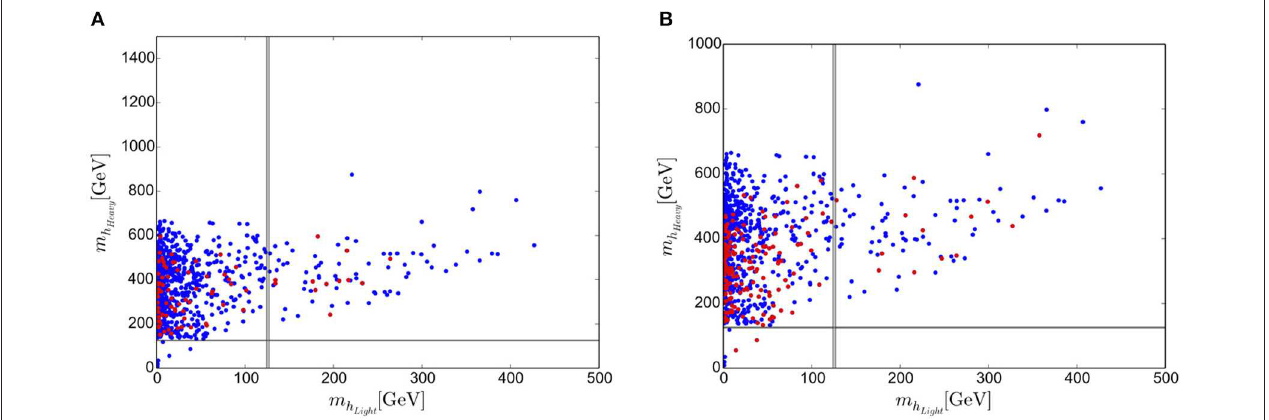
< 0.05 at M Pl . The gray bands highlight the SM Higgs mass 2 < 0.01. These plots originally 2